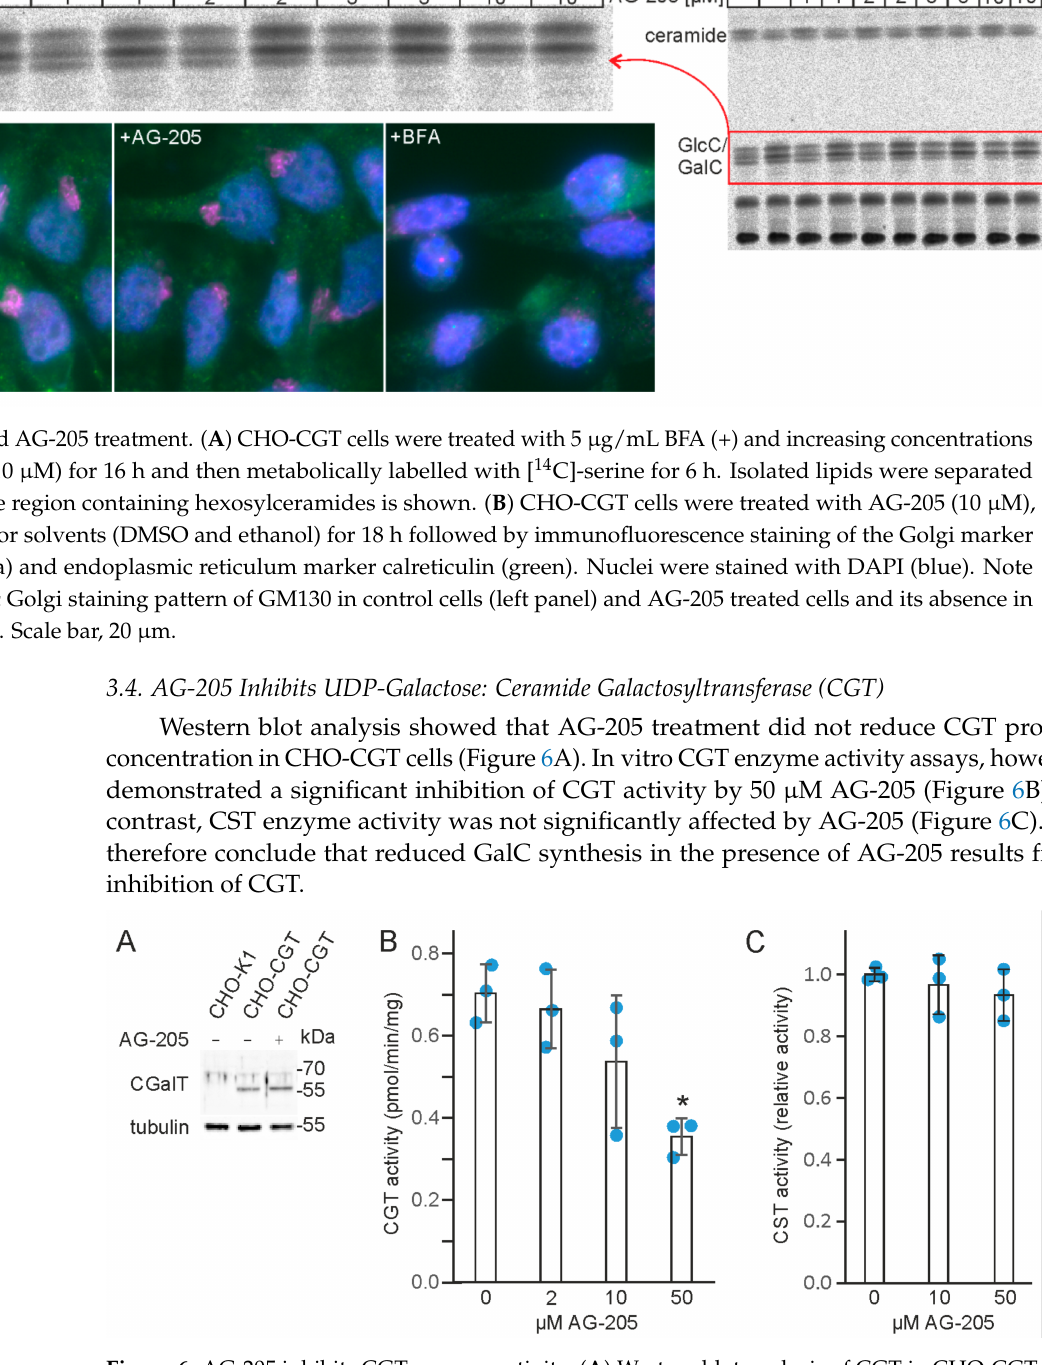
Figure 6. AG-205 inhibits CGT enzyme activity. ( A ) Western blot analysis of CGT in CHO-CGT cells treated with 10 µ M AG-205 (or DMSO as control). Untreated CHO-K1 cells served as negative control. The blot was reprobed with α -tubulin antibody to control for equal loading. ( B ) CGT enzyme activity assay ( n = 3). Activity was significantly inhibited by 50 µ M AG-205 (one-way ANOVA [F(3,8) = 7.089 ( p = 0.012) with post hoc Dunnett test (* p = 0.008)]. ( C ) CST enzyme activity assay ( n = 3). Relative CST activity is shown (mean of control set to 100%). No significant reduction of CST activity in the presence of AG-205 was observed using one-way ANOVA [F(2,6) = 0.604 ( p =